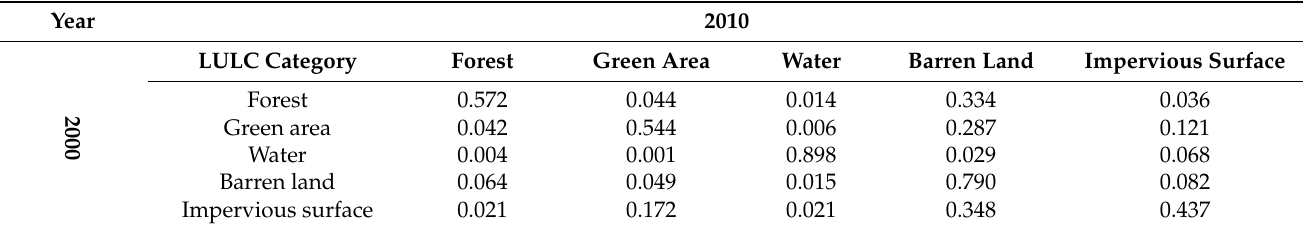
Figure 7. LULC gains and losses (1990–2020). Table 7. Transition matrix from 2000–2010.